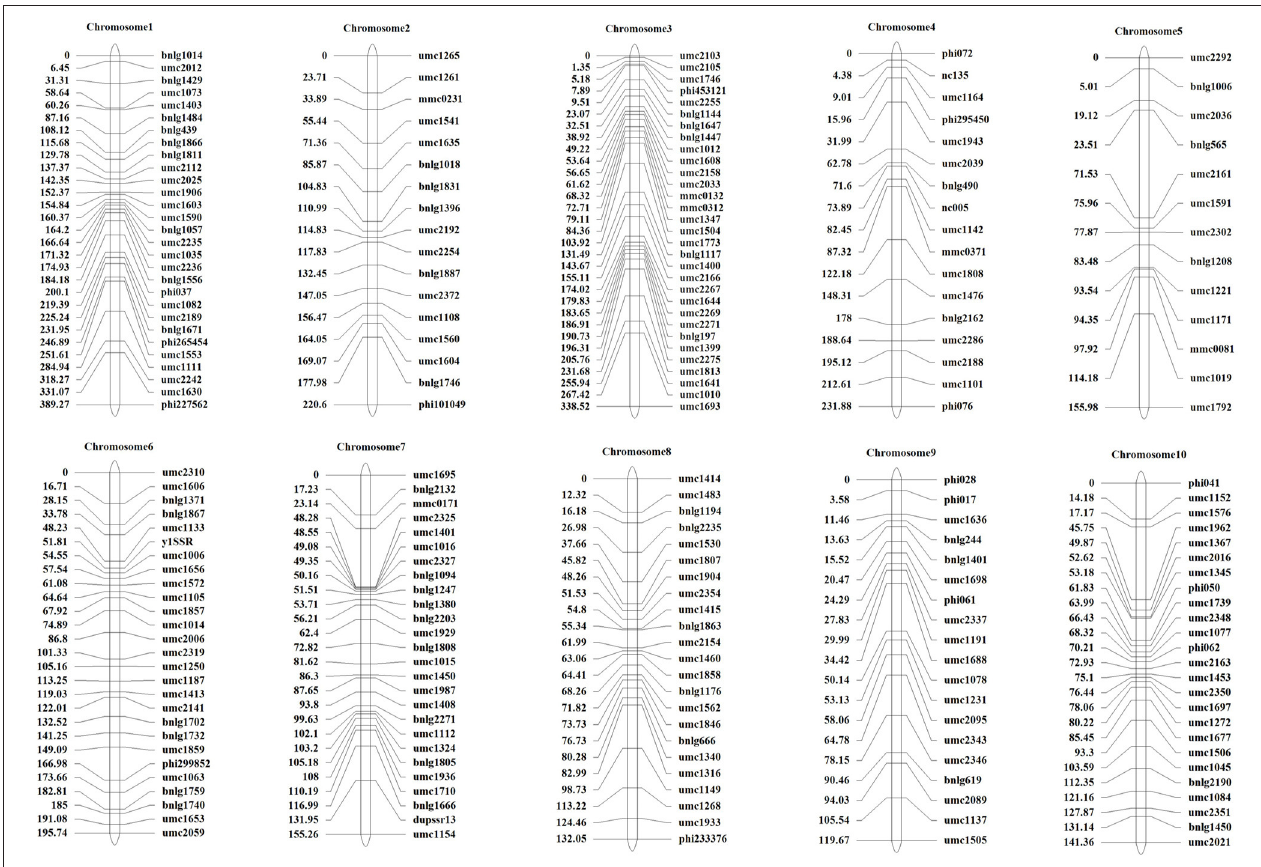
FIGURE 5 | SSR marker linkage map of 10 chromosomes in maize.